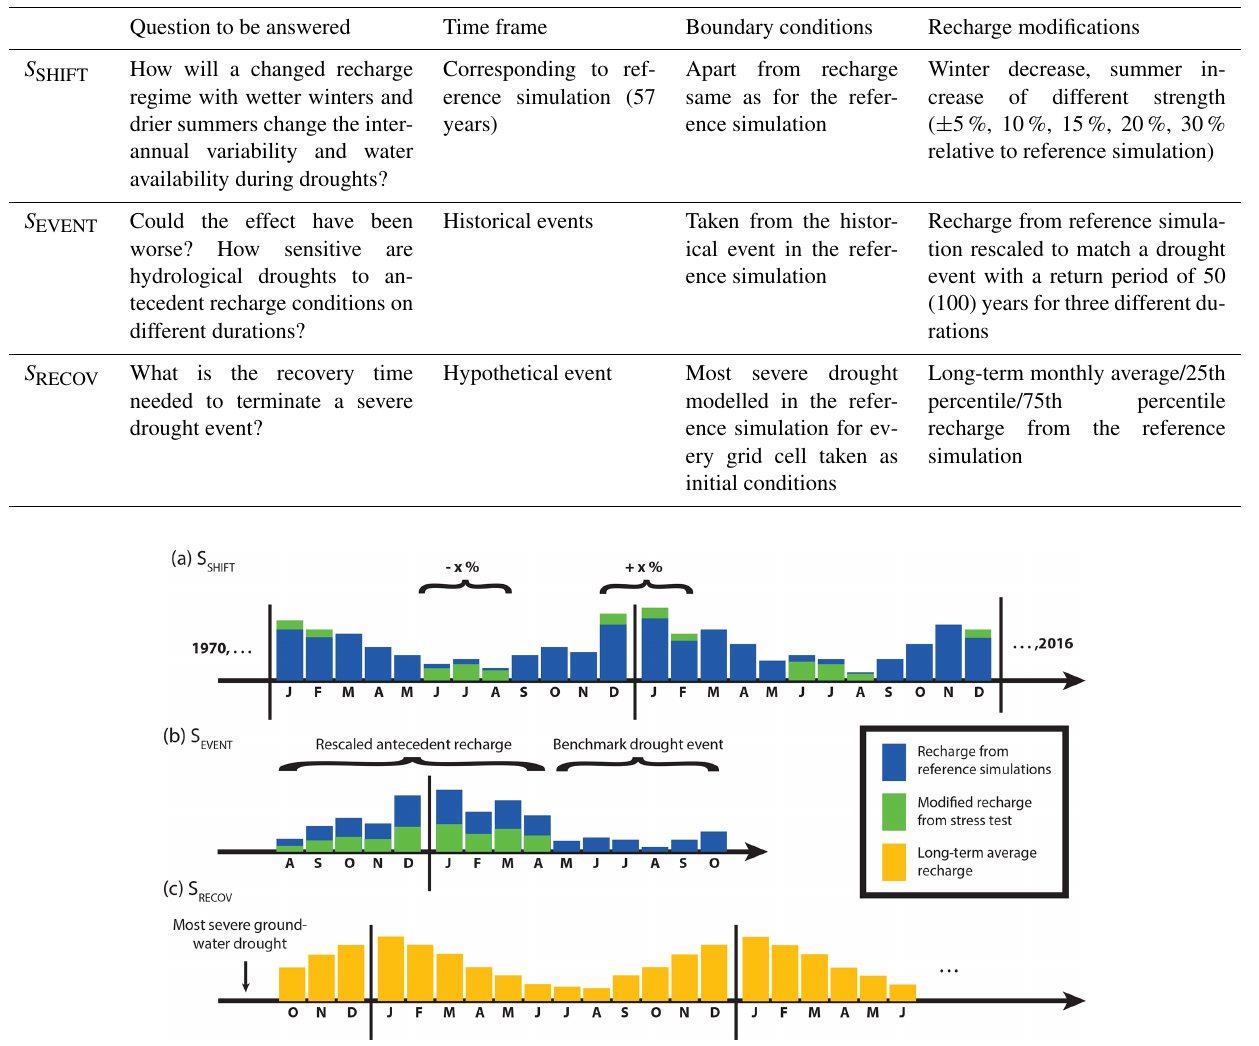
Figure 2. Recharge modifications used for the three different stress test types in this study.